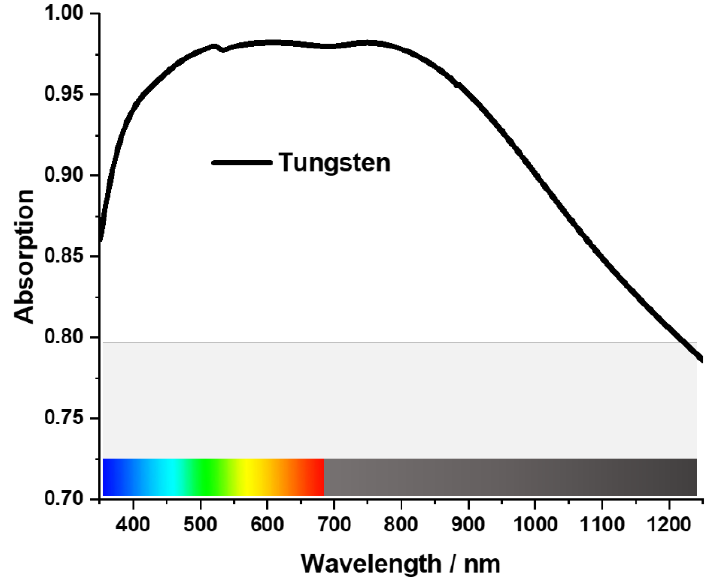
Figure 3. The Absorption of the MA.